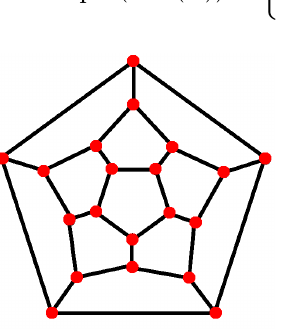
Figure 4. The graph which is cubic, 50-transmission regular and